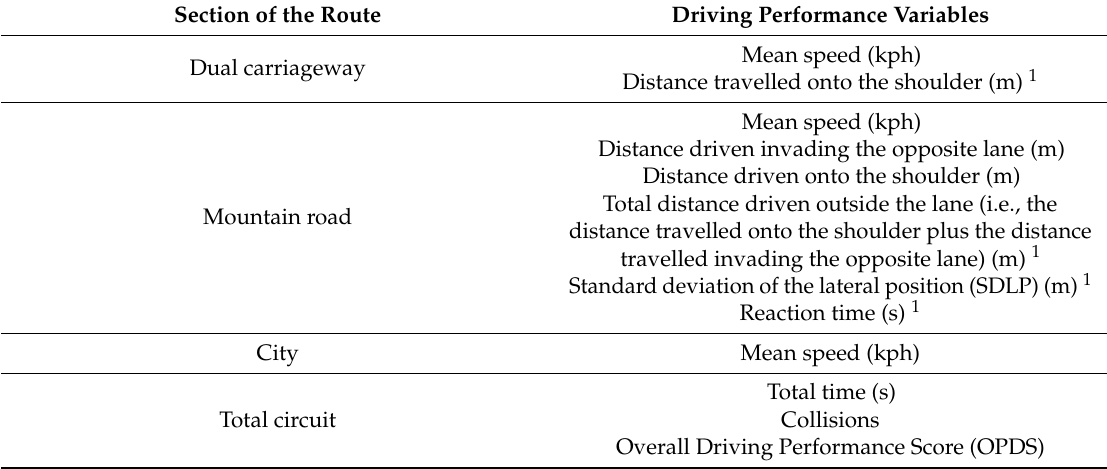
Table 1. Variables considered for assessing driving performance in the